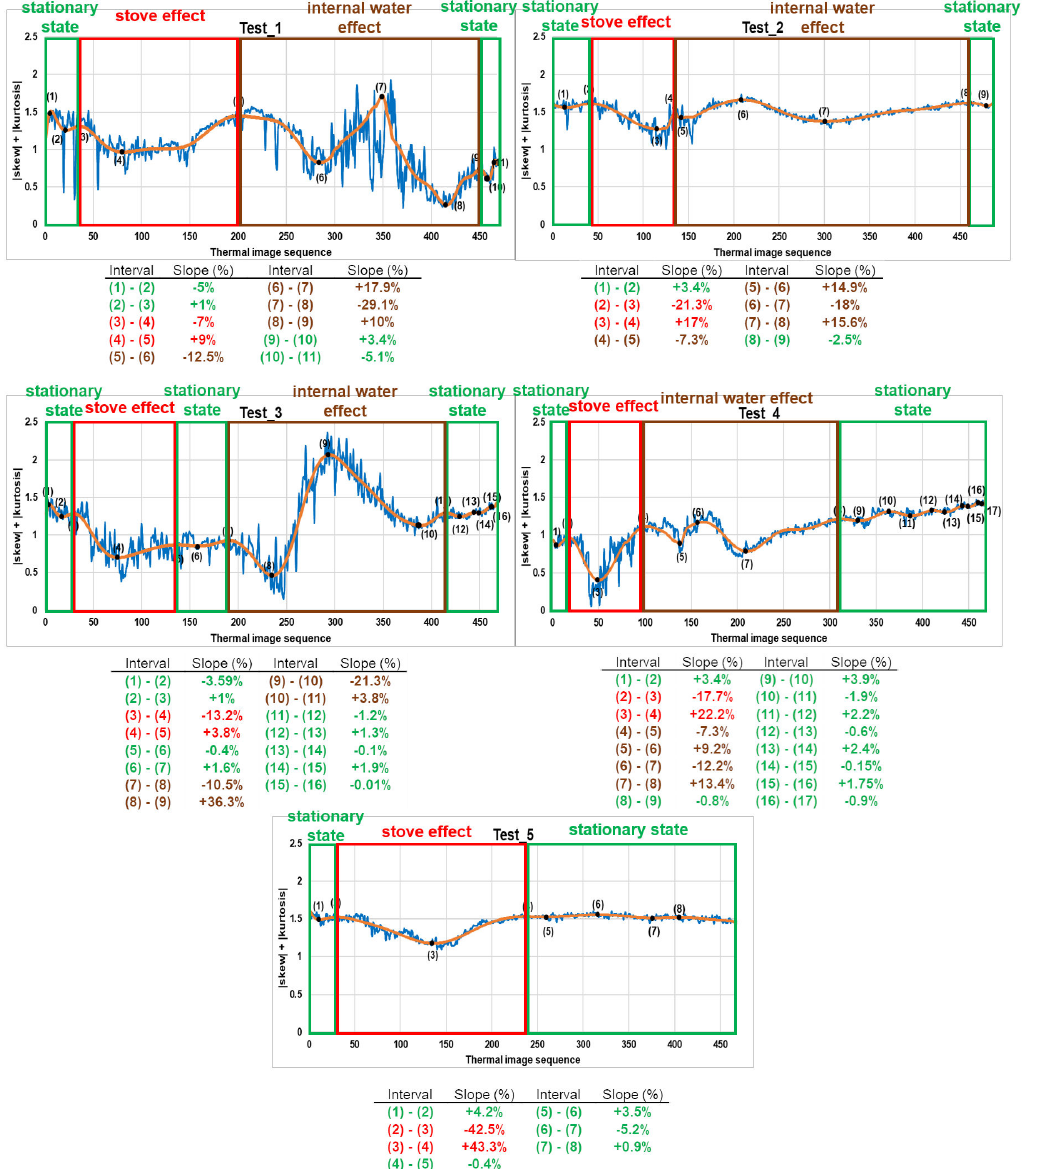
Figure 7. Relative maximums and minimums obtained (numbers indicated in the graph) and slope calculation (table below the graph) regarding the evolution of each test performed after SG smoothing filter application (orange line). Blue lines indicate the evolutions of the tests performed before SG smoothing filter application. The slopes belonging to the stationary state of the mosaic, the stove e ff ect and the internal water e ff ect ( w_shape ) are framed in green, red and brown rectangles in the graphs; and coloured with the same colours as their corresponding rectangles in the tables, respectively. The reference_points are the instants just after the beginning of internal water e ff ect, i.e., the thermal images just after the extremes (5), (4), (7) and (4) of tests 1, 2, 3 and 4,